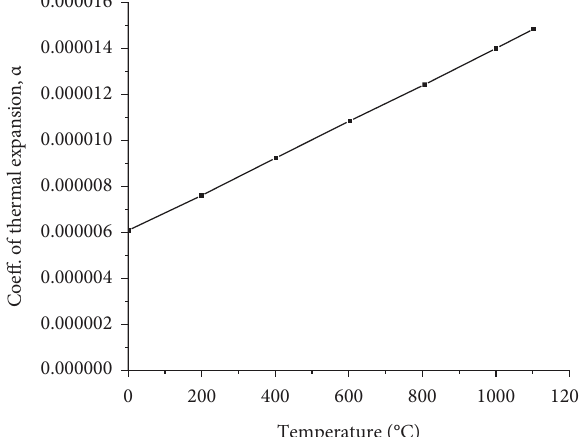
Figure 11: Concrete secant thermal expansion coefcient variation with temperatures [19].